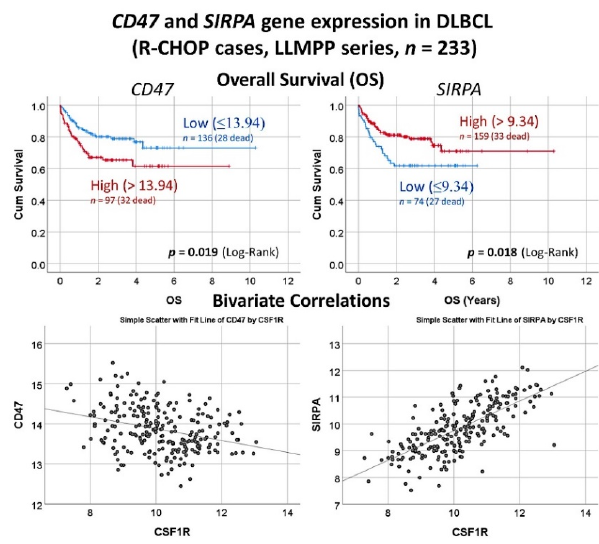
Figure 18. Gene expression analysis of CD47 and SIRPA in the diffuse large B-cell lymphoma. In the series of the Lymphoma/Leukemia Molecular Profiling Project (LLMPP), when analyzing only the cases with R-CHOP-like treatment, high CD47 but low SIRPA correlated with poor overall survival of the patients, and SIRPA positively correlated with CSF1R . CD47 is a ligand for SIRPA (SIRPα), a protein expressed by macrophages and dendritic cells. These two markers belong to the immune checkpoint pathway, and mediate a negative regulation of phagocytosis. R-CHOP, rituximab, cyclophosphamide, doxorubicin hydrochloride, vincristine, and prednisolone; LLMPP, Lymphoma/Leukemia Molecular Profiling Project; OS, overall survival.